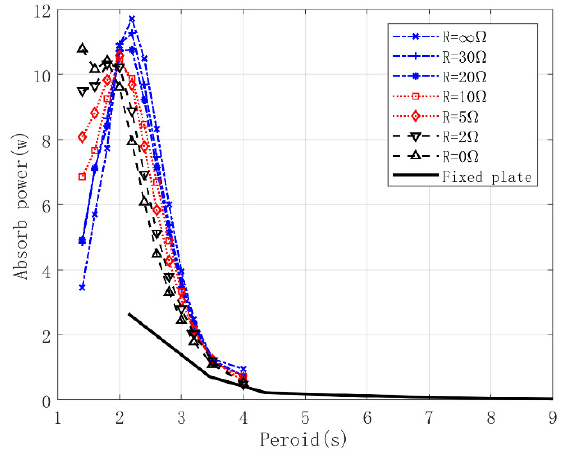
Figure 20. The consumed power of the fixed heave plate and THP1 with different LRs.